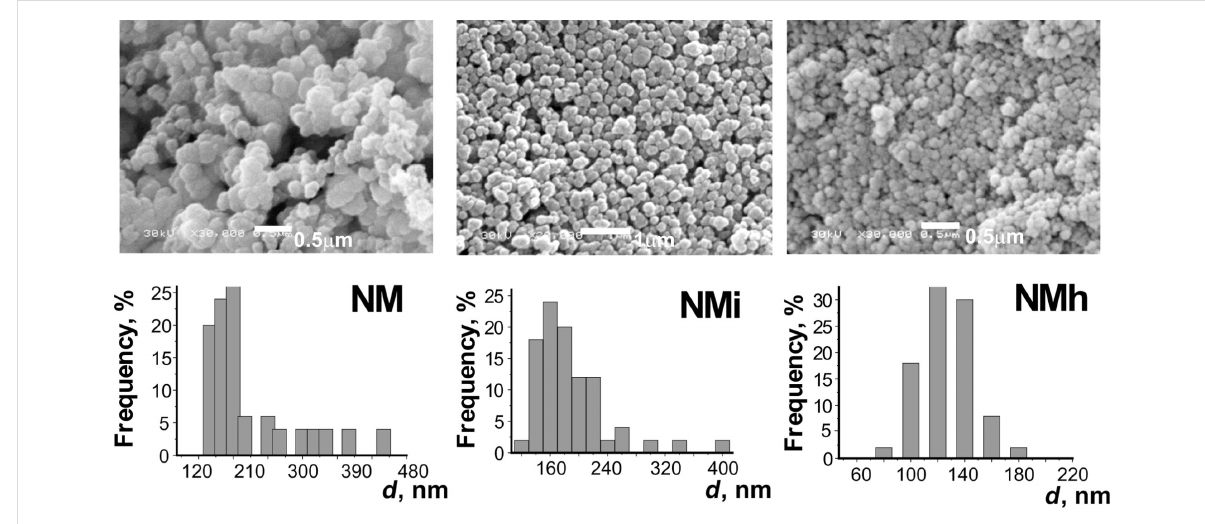
Figure 1: SEM images and particle size distribution curves for amino/methyl-containing samples NM , NMi , NMh .